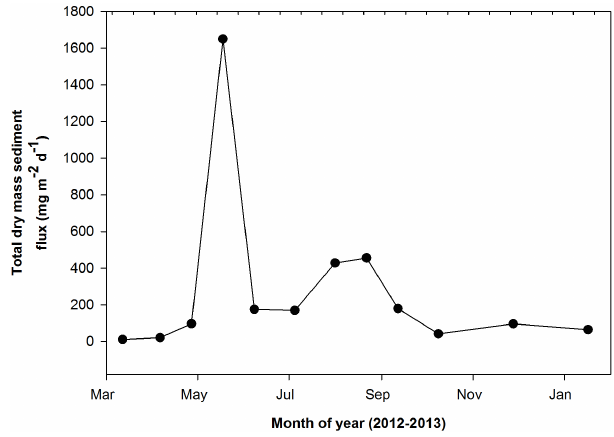
Figure 5. Total dry mass sediment fluxes (mgm − 2 d − 1 ) for monthly sequencing traps, positioned at 100m water depth in the South Basin of Lake Baikal